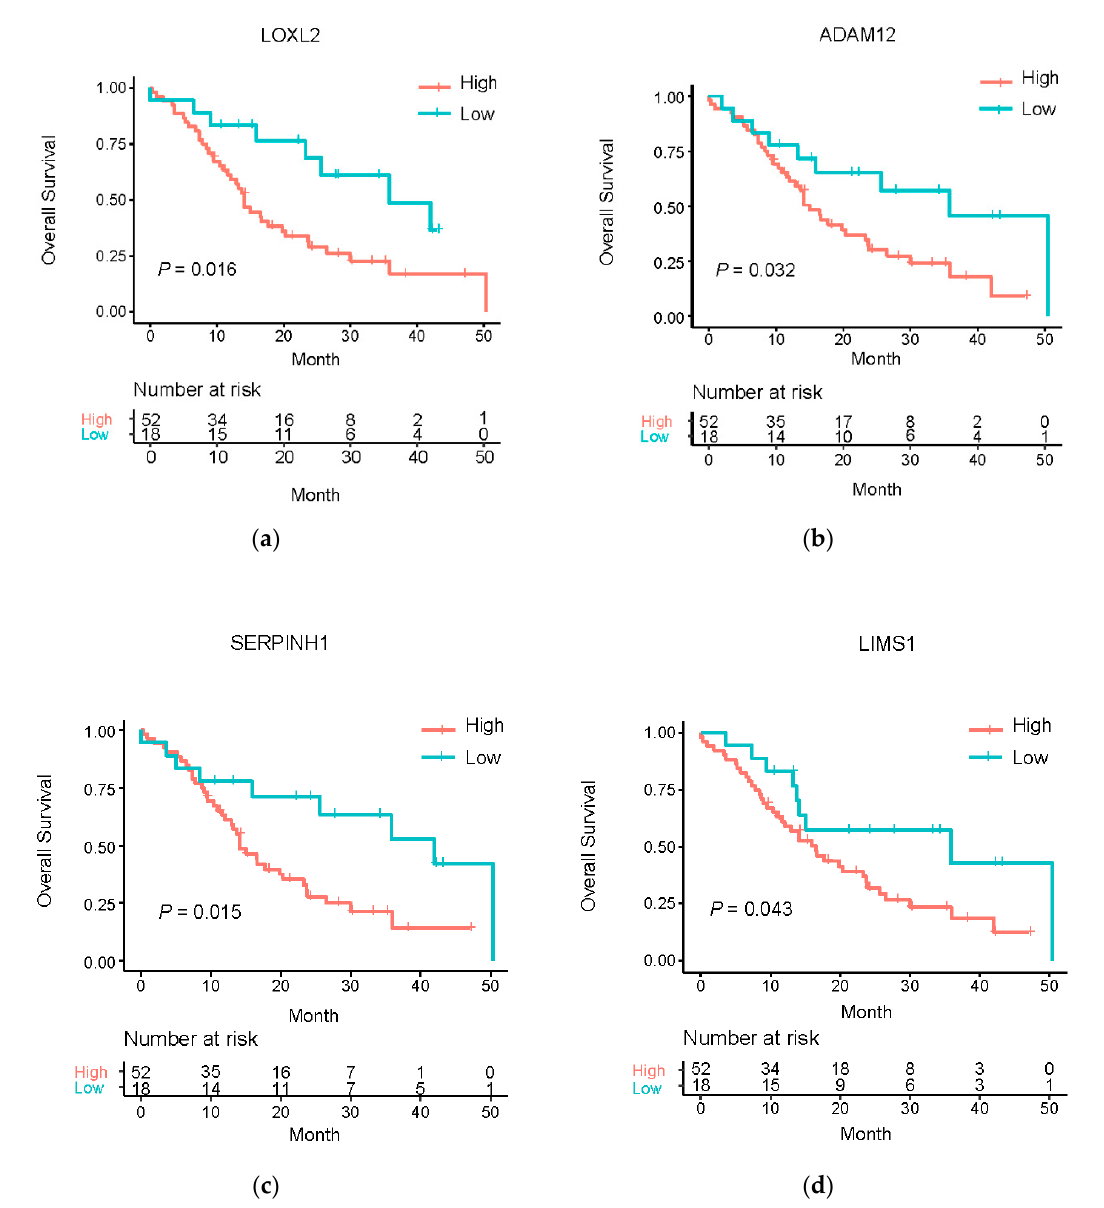
Figure 6. Kaplan-Meier survival analysis showing the clinical relevance of the target genes regulated by miR-29c in the Bailey dataset. ( a,b ) Kaplan–Meier curves illustrating the overall survival of PDAC patients in the two subgroups stratified based on the expression of LOXL2 and ADAM12, respectively (cutoff: 25% percentile). ( c,d ) Kaplan–Meier curves illustrating the overall survival of PDAC patients in the two subgroups stratified based on the expression of SERPINH1 and LIMS1, respectively (cutoff: 25% percentile).